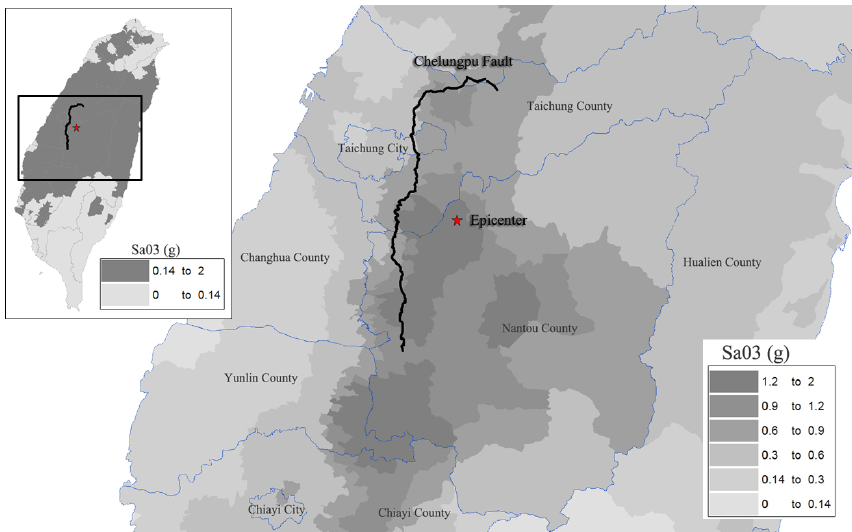
Figure 1. Epicenter, Chelungpu Fault and distribution of seismic intensity of the 1999 Chi-Chi earthquake, Taiwan. Note: Sa03 stands for spectral acceleration at 0.3s. Sa03 greater than 0.14 g is generally considered the threshold that would result in destructive damage and